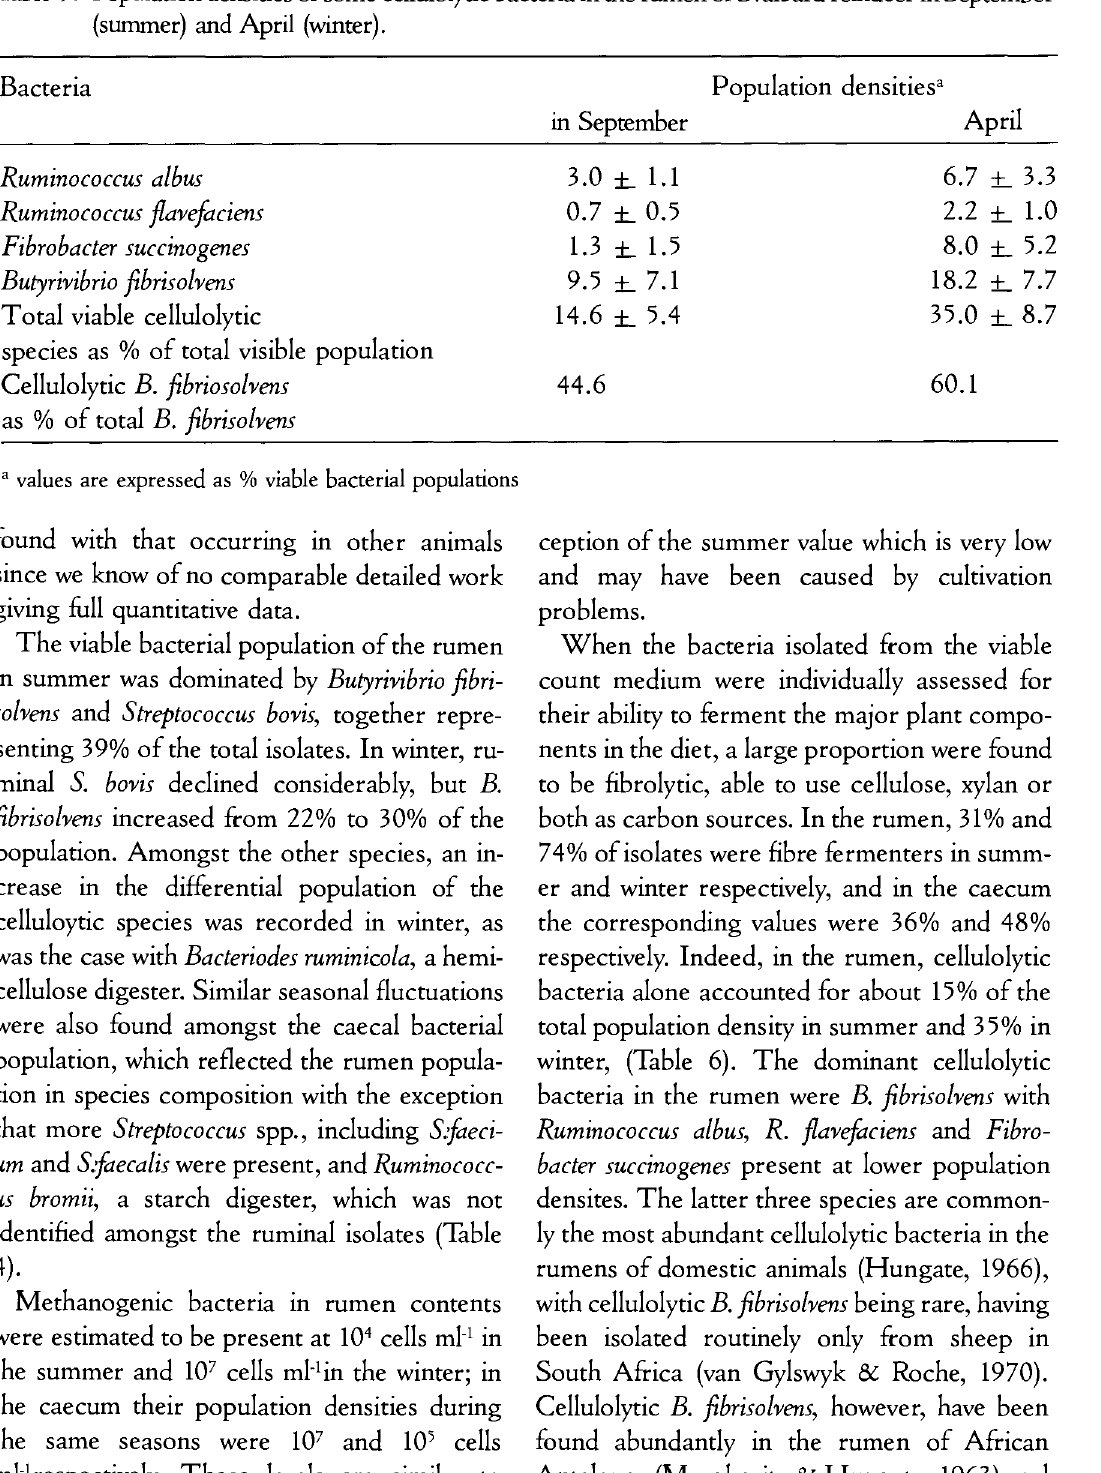
Table 5. Population densities of some cellulolytic bacteria in the rumen of Svalbard reindeer in September (summer) and April